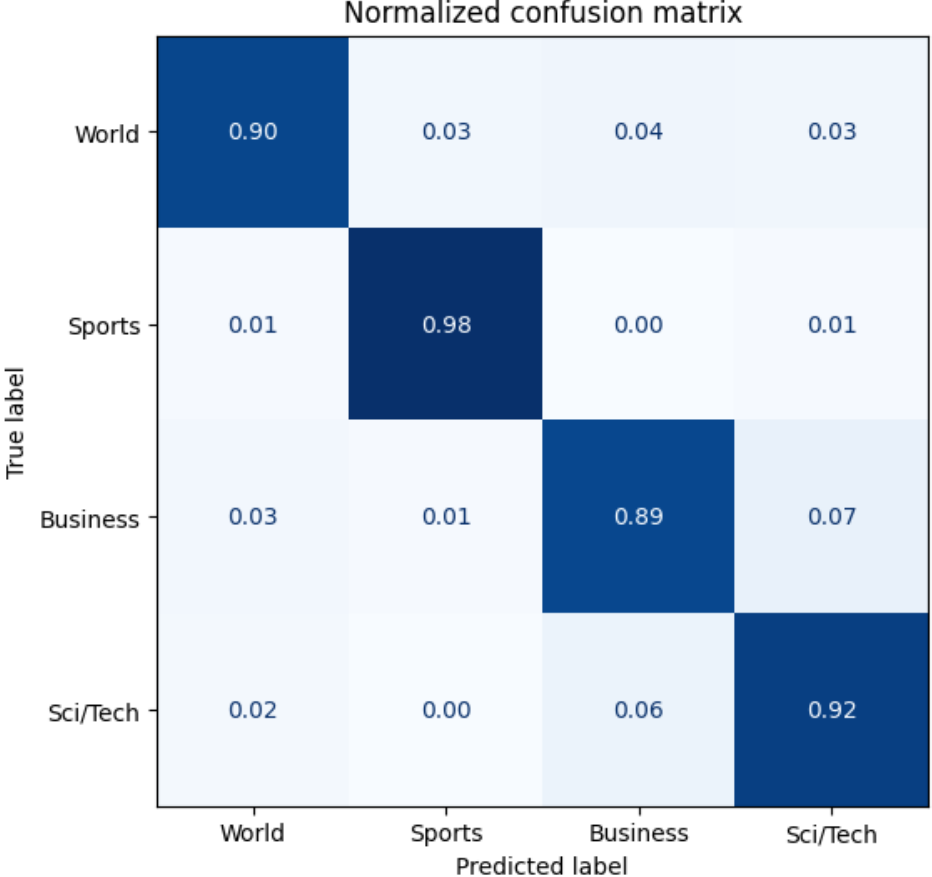
Figure 13. Original Model Confusion Matrix on AG-News.